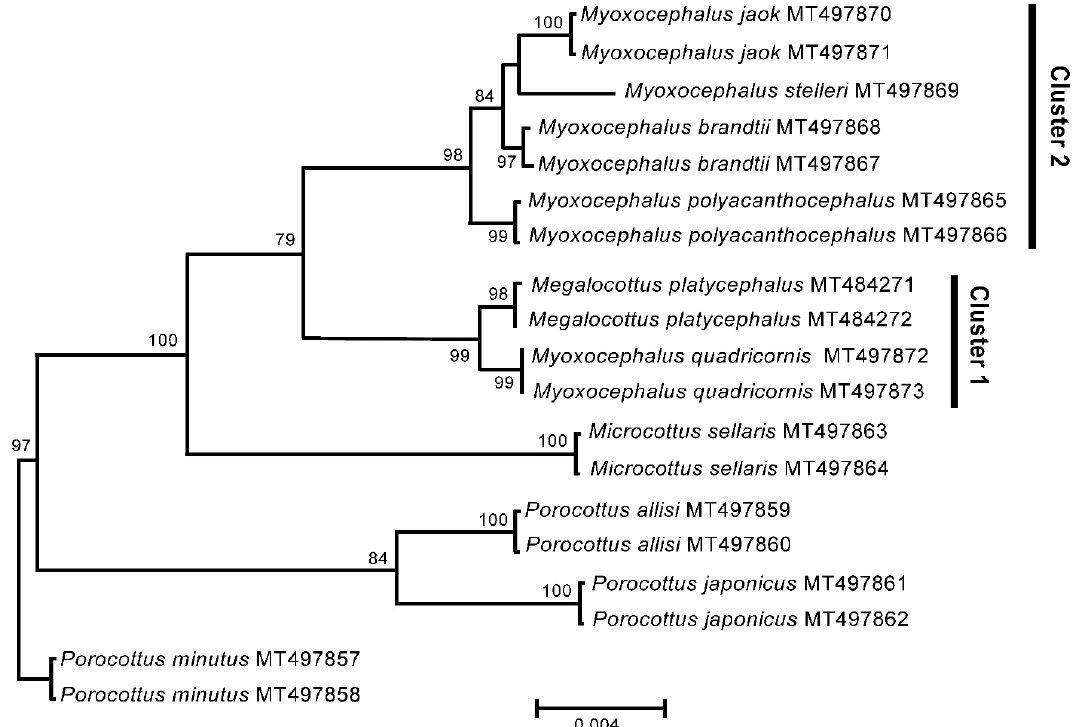
Figure 2. Maximum likelihood tree for the fourhorn sculpin Myoxocephalus quadricornis and members of the family Cottidae from GenBank inferred from the 6332 bp ribosomal DNA. The tree is based on the Tamura-Nei (TN93) model of nucleotide substitution. For other comments, see Figure 1. Nuclear ribosomal genes are frequently used in molecular systematics [63,64]. Both small (18S) and large (28S) ribosomal genes, characterized by slow rate of evolution, have been used for